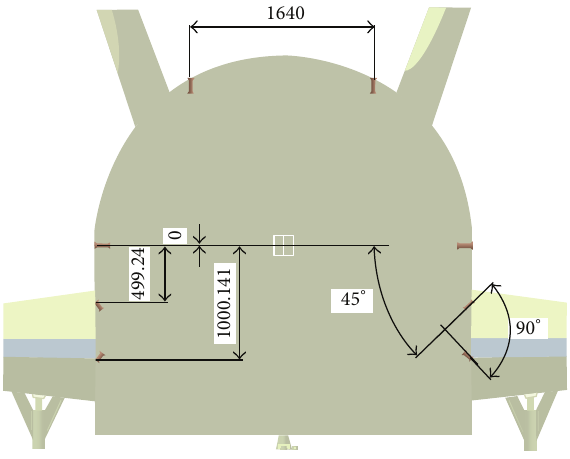
Figure 7: Thrusters lateral layout map.